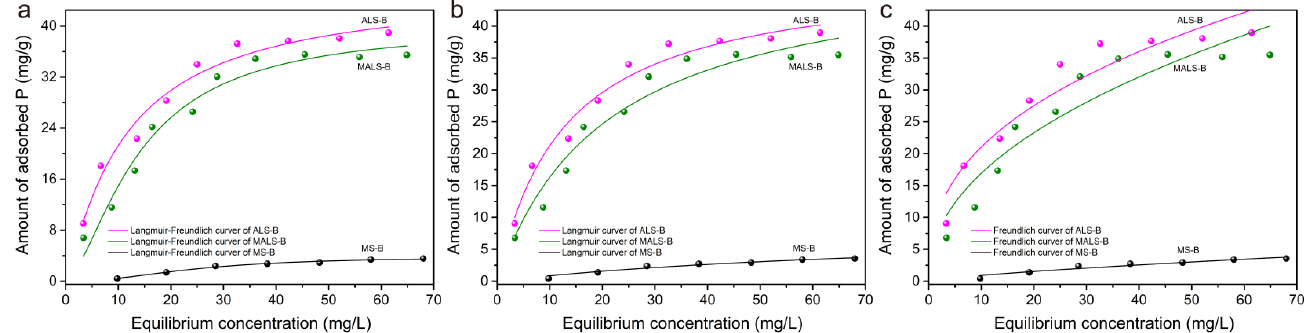
Figure 6. Phosphate adsorption isotherms of MALS-B, ALS-B, and MS-B with results fitted to the ( a ) Langmuir–Freundlich, ( b ) Langmuir, and ( c ) Freundlich models. Table 1. Comparison of phosphorus adsorption capacity to other hydrogel beads.